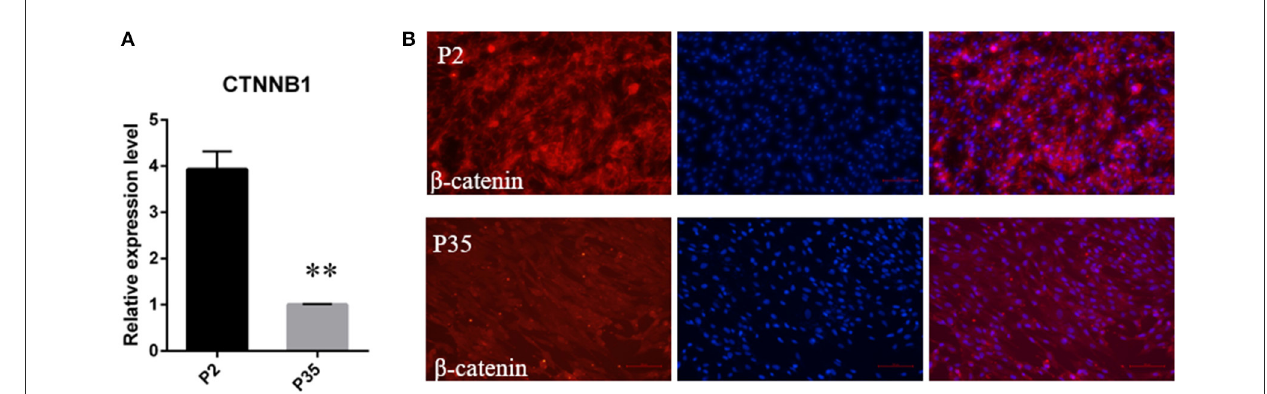
FIGURE4 The change of Wnt/ β -catenin signaling activity during a period of culture ex vivo . (A) qRT-PCR of CTNNB1, the transcriptional coactivator of Wnt signaling, in passage 2 and passage 35 DPCs. (B) Immunofluorescence Staining of β -catenin in early passaged ovine DPCs and multiple passaged DPCs. ** P <